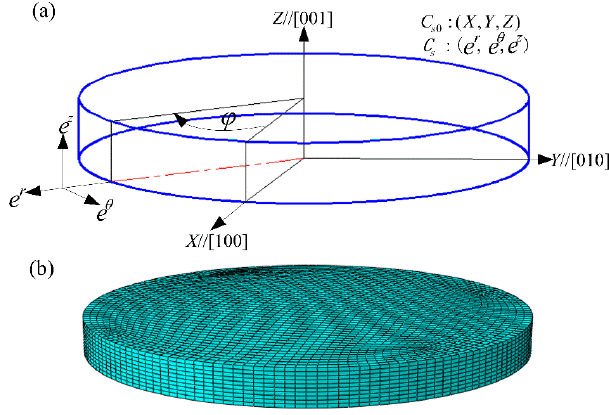
Figure 1. Three-dimensional HPT model: ( a ) configuration of the sample and coordinate systems, ( b ) meshes of the sample. Table 1. Parameters in the constitutive model.